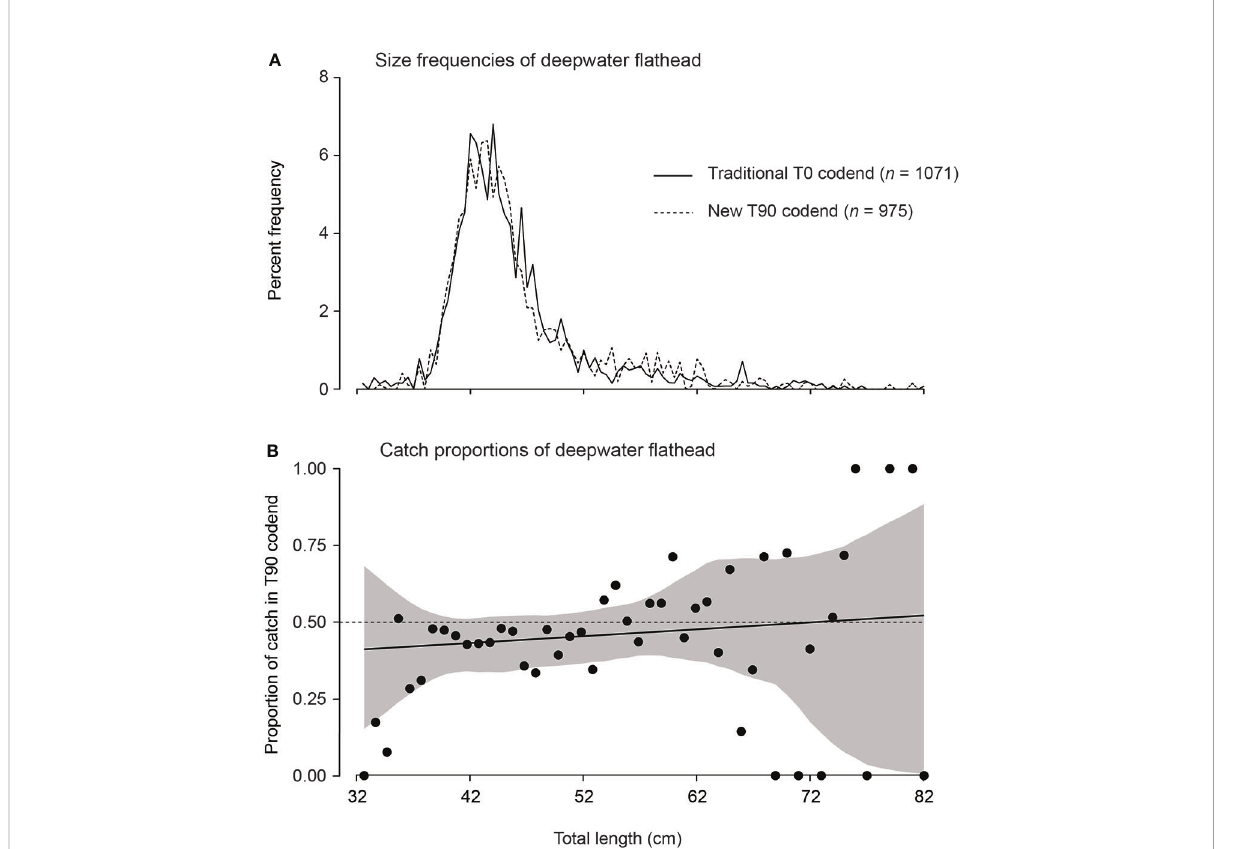
FIGURE 2 (A) Relative size-frequency plots for deepwater fl athead, Neoplatycephalus conatus , retained in the traditional T0 and new T90 codends, and (B) plot of catch proportions with 95% con fi dence intervals designated by the shaded area and the horizontal dashed line marking 50%